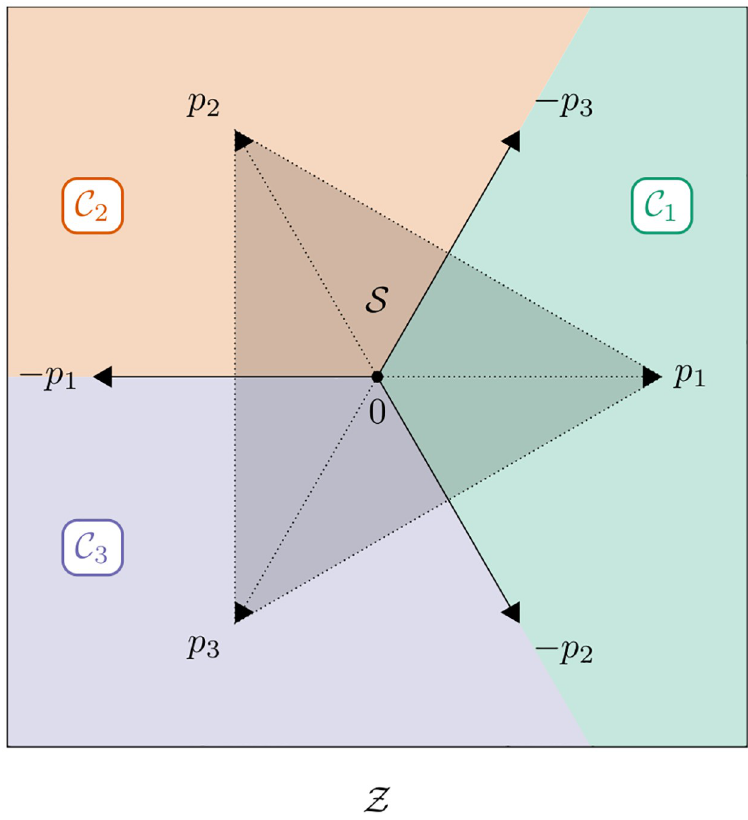
Fig 2. Segmentation of the latent space. Segmentation of the latent space Z ¼ R 2 of a ternary classification problem ( n = 3) into three congruent cone segments C respective colors. The vertices p 1 , p 2 , p 3 of the simplex S (marked by the gray shading) with barycenter 0 lie on the central ray of the respective segments. The borders of the segments are defined by the vertices − p 1 , − p 2 , − p 3 of the mirrored simplex (cid:0) S